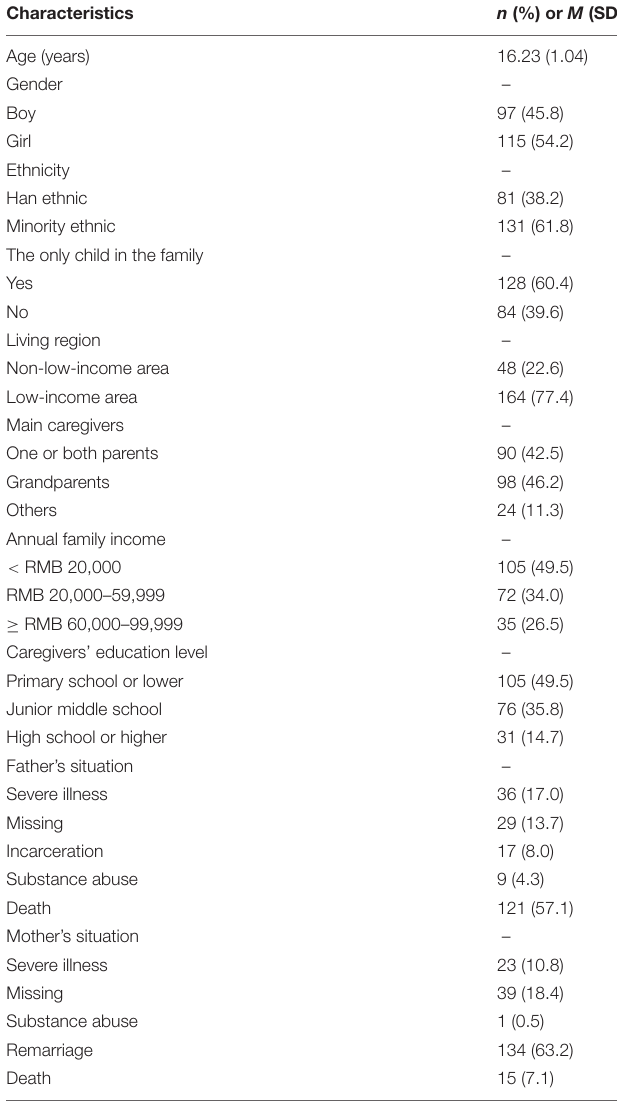
TABLE 1 | Demographic characteristics of the